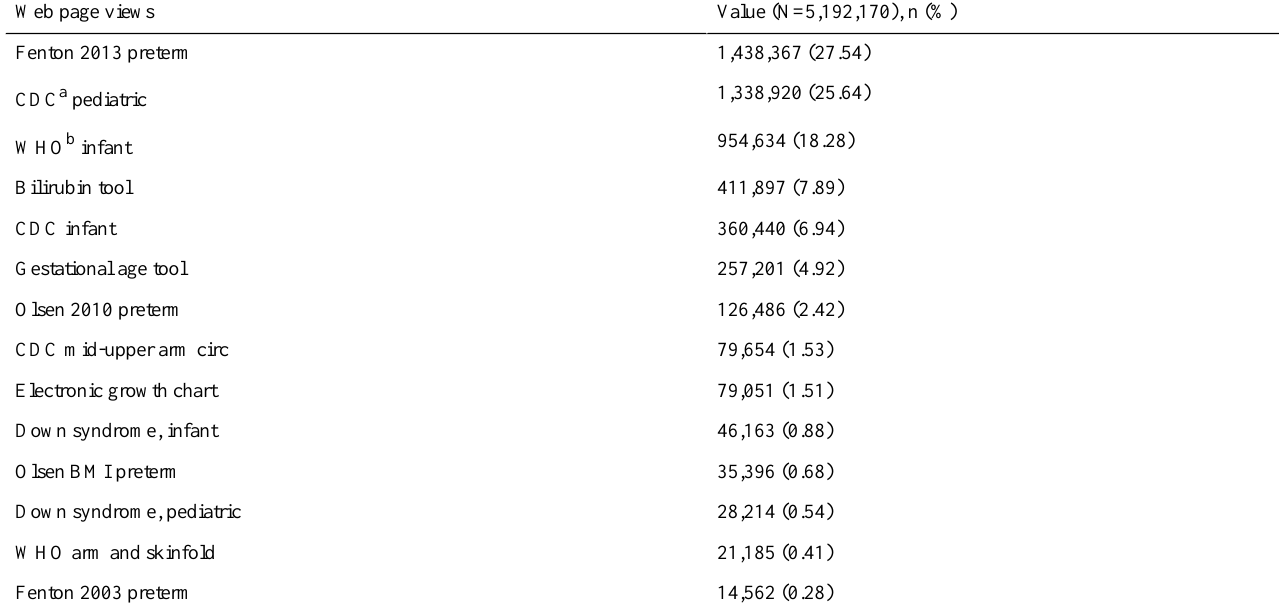
Table 2. PediTools page views by calculator for year ending June